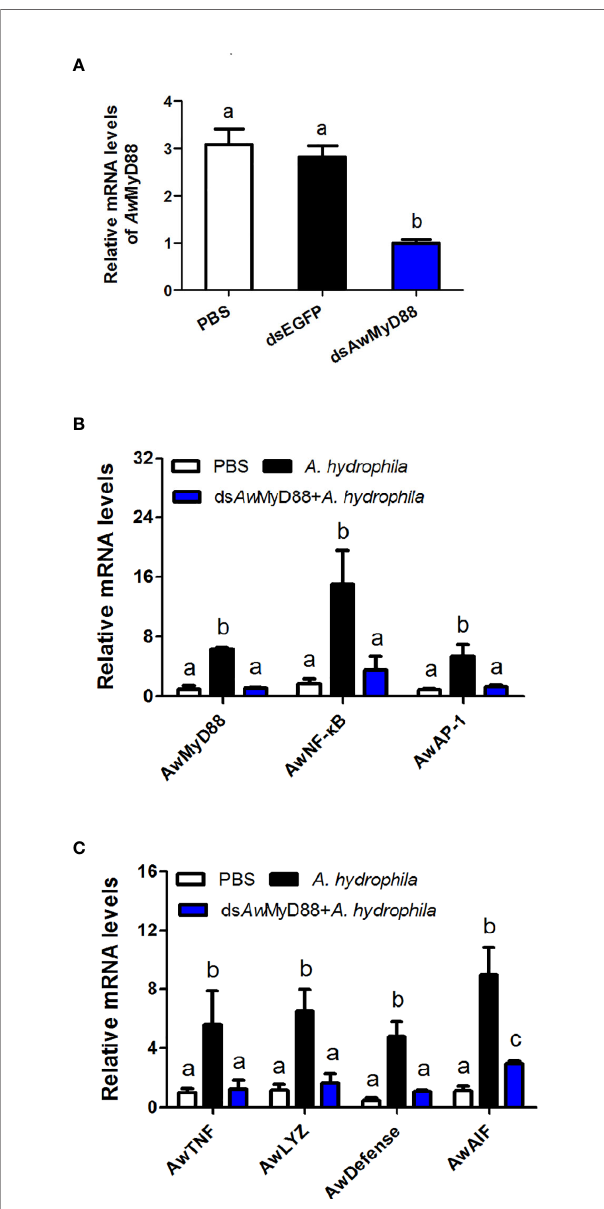
FIGURE 7 | Effects of Aw MyD88 knockdown on the expression of Aw MyD88 (A) and immune-related genes (B, C) in hemocytes of A. woodiana . The b -actin gene served as an internal reference gene to normalize the expression level. Each bar represents the mean of the normalized expression levels of the replicates ( N = 3). Signi fi cant differences between the immune challenge and control groups are indicated by different letters (P <